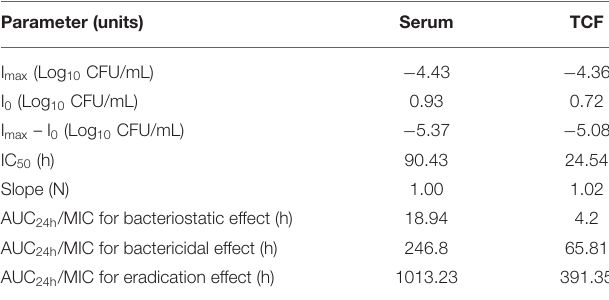
TABLE 4 | Values of ex vivo PK/PD parameters and AUC 24h /MIC required to achieve various degrees of antibacterial efficacy in serum and